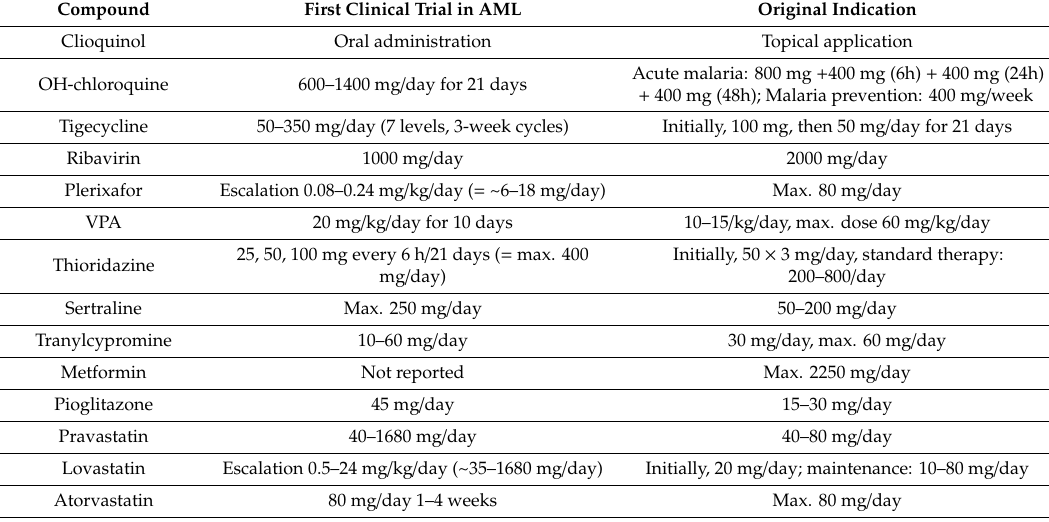
Table 4. New and old dosing of repurposed compounds in